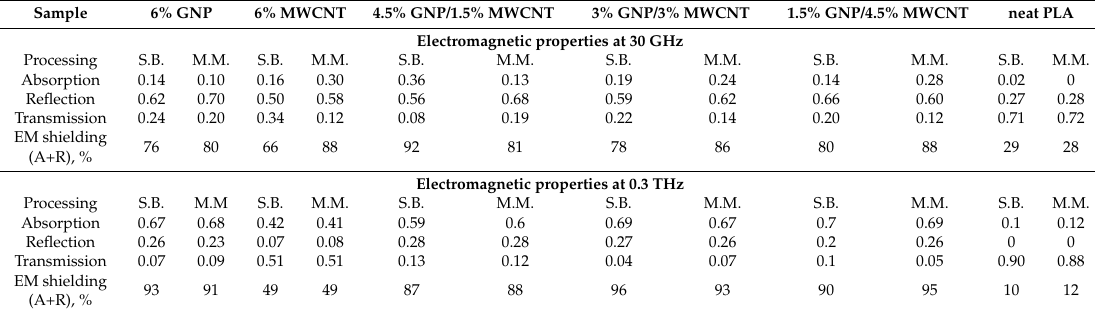
Table 4. Electromagnetic properties of 6 wt % filled samples at 1 mm and 0.3 mm in GHz and THz frequency ranges respectively, prepared by solution blending and melt